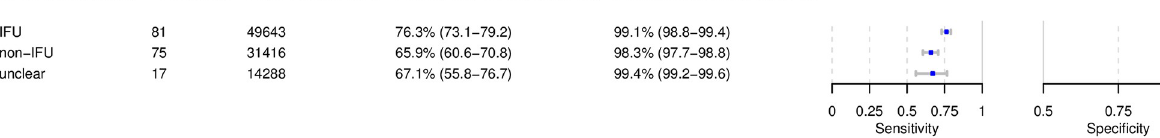
Fig 7. Pooled sensitivity and specificity by instructions for use (IFU) conformity.